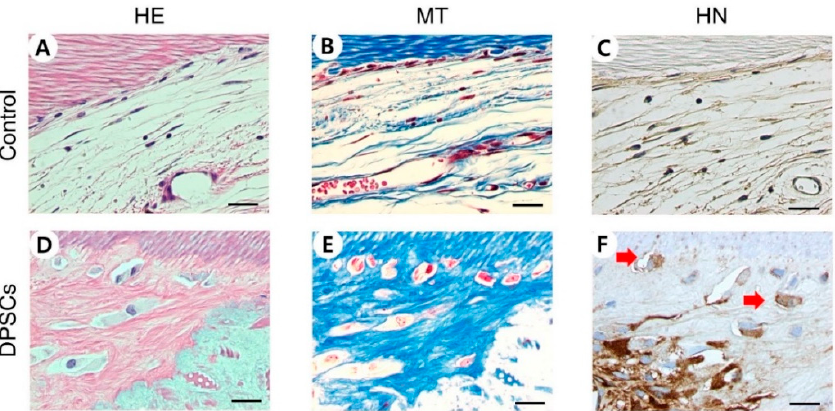
Figure 4. Histological characteristics of recellularized dHDP transplants with DPSCs. ( A , D ) HE staining. ( B , E ) MT staining. ( C , F ) HN staining. HE, MT, and HN staining showed that dHDP transplants were recellularized. Recellularized cells are indicated by red arrows. Scale bars: 20 μ m. Abbreviations: dHDP, decellularized human dental pulp; DPSCs, dental pulp stem cells; HE, hematoxylin and eosin; MT, Masson’s trichrome; HN, human nuclei.